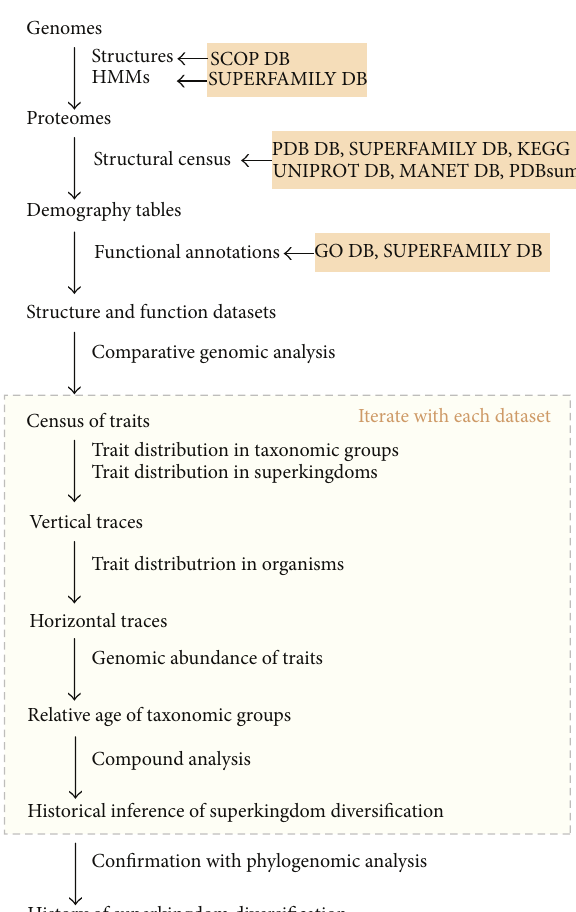
Figure 1: Overview of the comparative proteomics and functio- nomics methodology. Proteomes and functionomes were scanned for the occurrence and abundance of FSFs and GO terms (i.e., traits). This information was represented in data matrices that were analyzed for trends of trait sharing and traces of vertical and horizontal inheritance. Inferences were drawn regarding superking- dom diversification and were confirmed with previously published phylogenetic